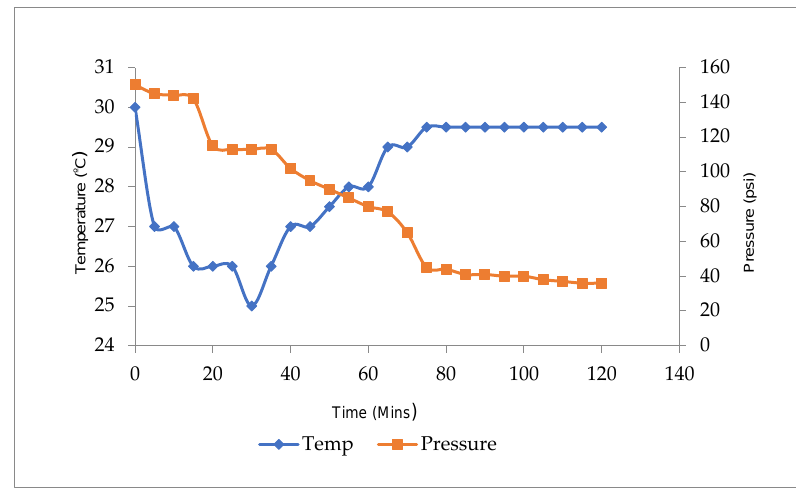
Figure 3. Pressure and Temperature versus Time for Water and Gas System.